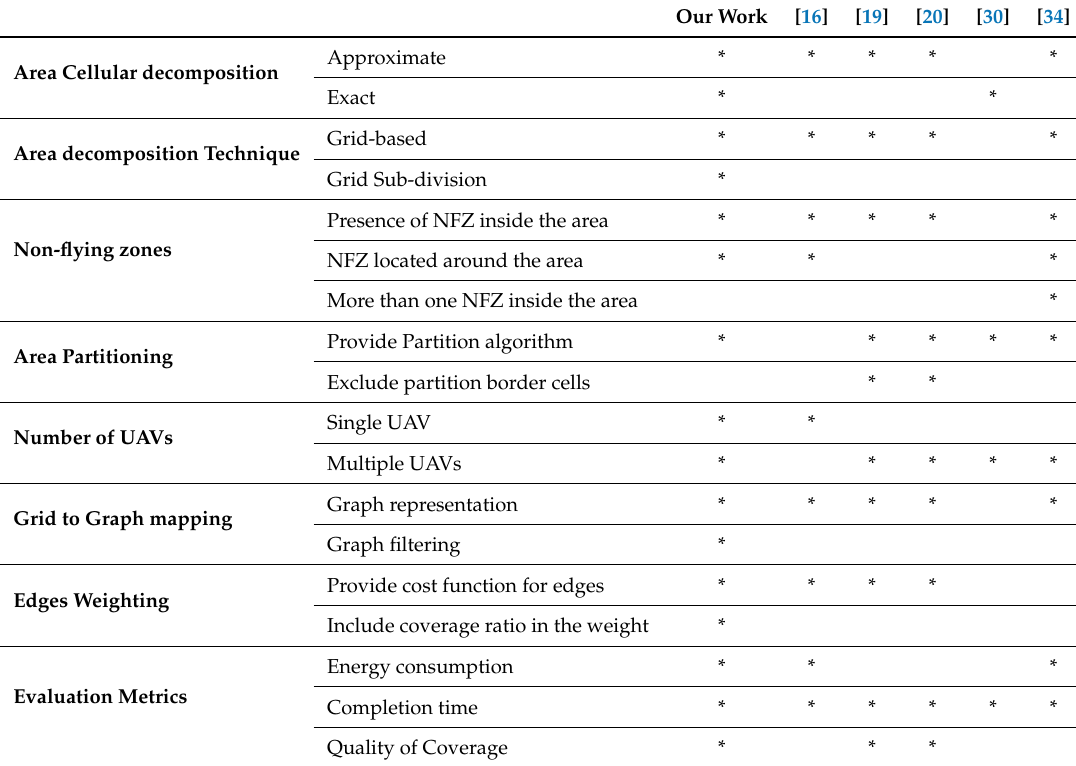
Table 1. Comparison table of our approach over related works in this